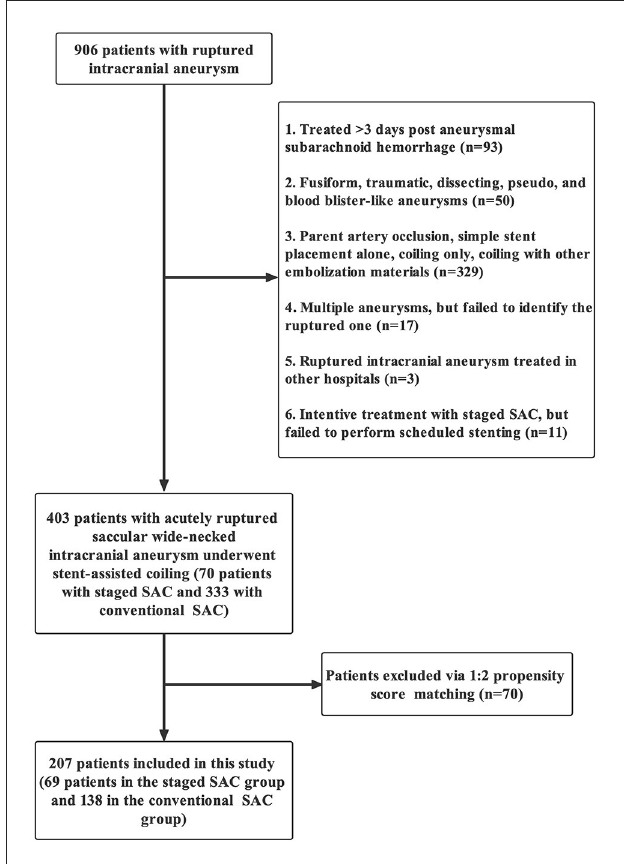
FIGURE1 Flow diagram of patient selection according to the inclusion and exclusion